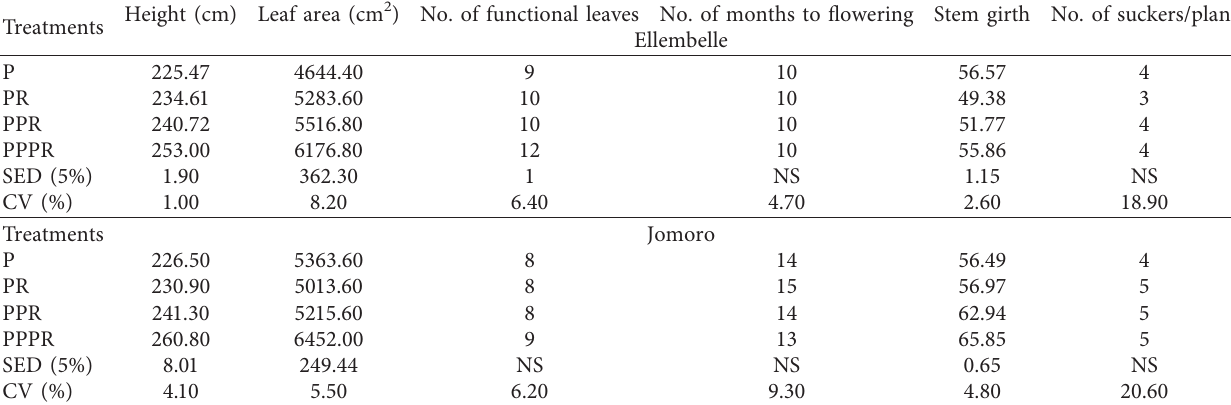
Table 6: Morphological and flowering characteristics of intercropped plantain at Ellembelle and